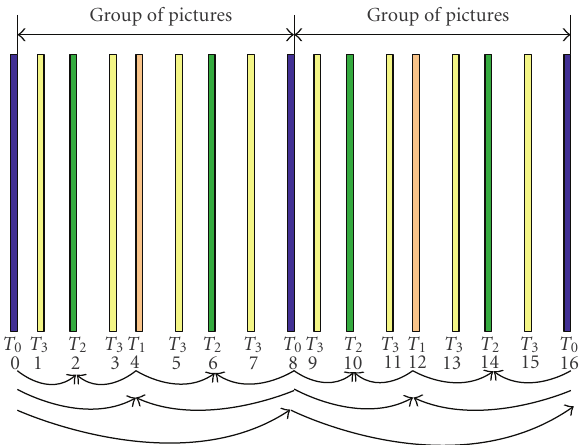
Figure 2: H.264 group of pictures (GOP) structure for temporal scalability.